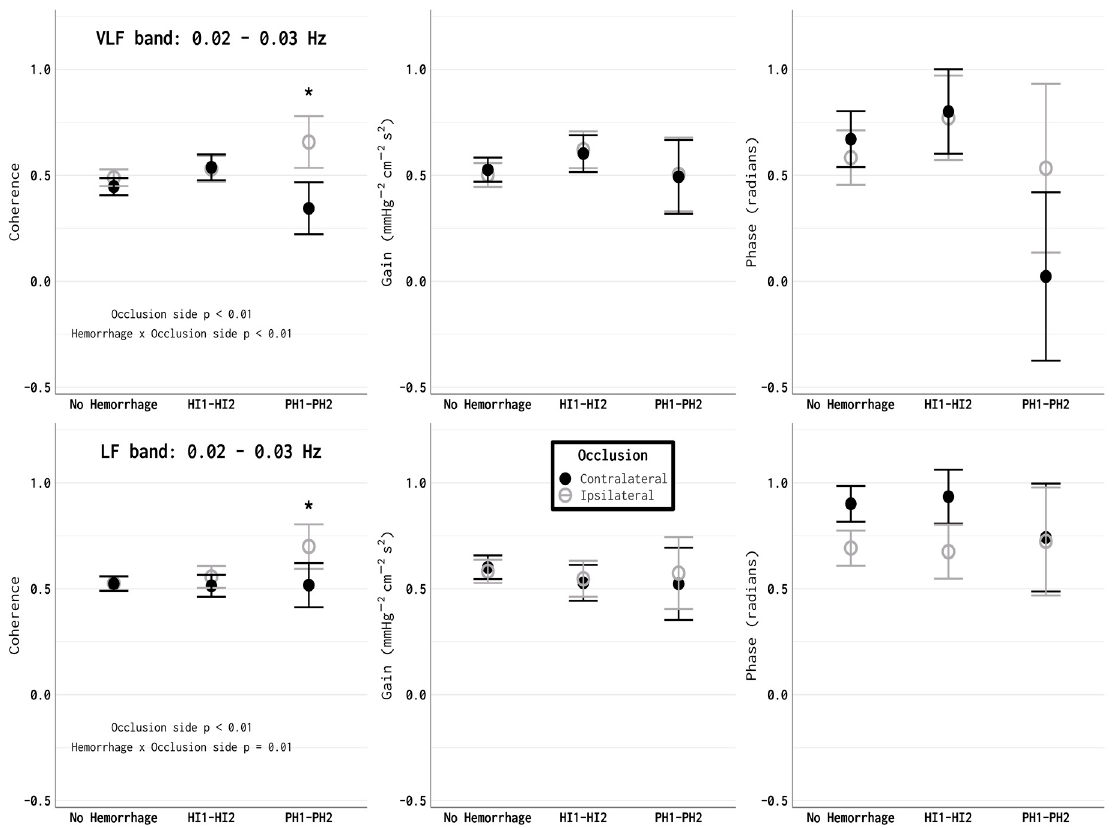
Figure 2. A PH1–PH2 (parenchymal hematoma types 1 and 2) hemorrhagic transformation was associated with impaired autoregulation in the ipsilateral hemisphere. In both of the VLF and LF bands, coherence on the ipsilateral side was significantly higher compared to the contralateral hemisphere in patients with a PH1–PH2 hemorrhagic transformation (* p < 0.01). The phase and gain were not significantly different between the ipsilateral and contralateral hemispheres in this group (for both the VLF and LF bands).